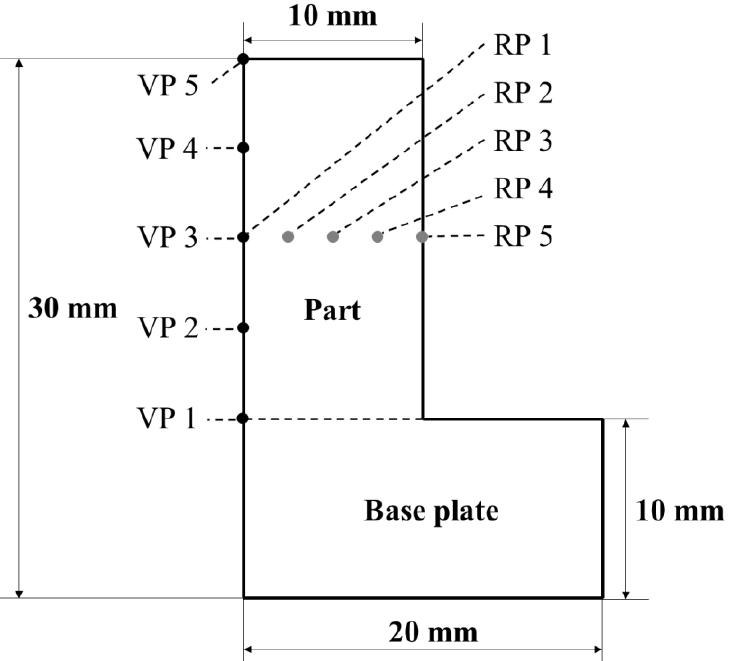
Figure 1. Geometry of the simulation domain and position of sampling points (“VP” for sampling points along the centreline i.e., height of cylindrical sample, “RP” for sampling points along the radius of cylindrical sample at its mid-height).